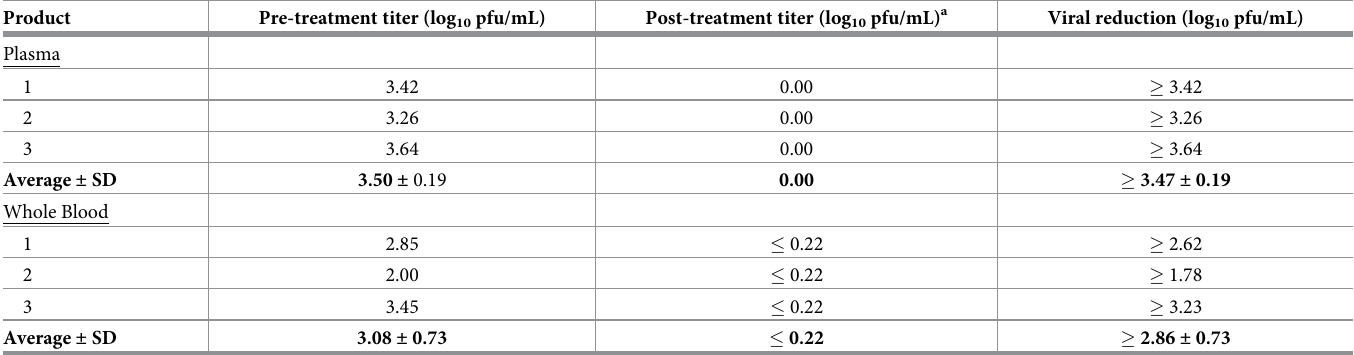
Table 3. Viral titers pre- and